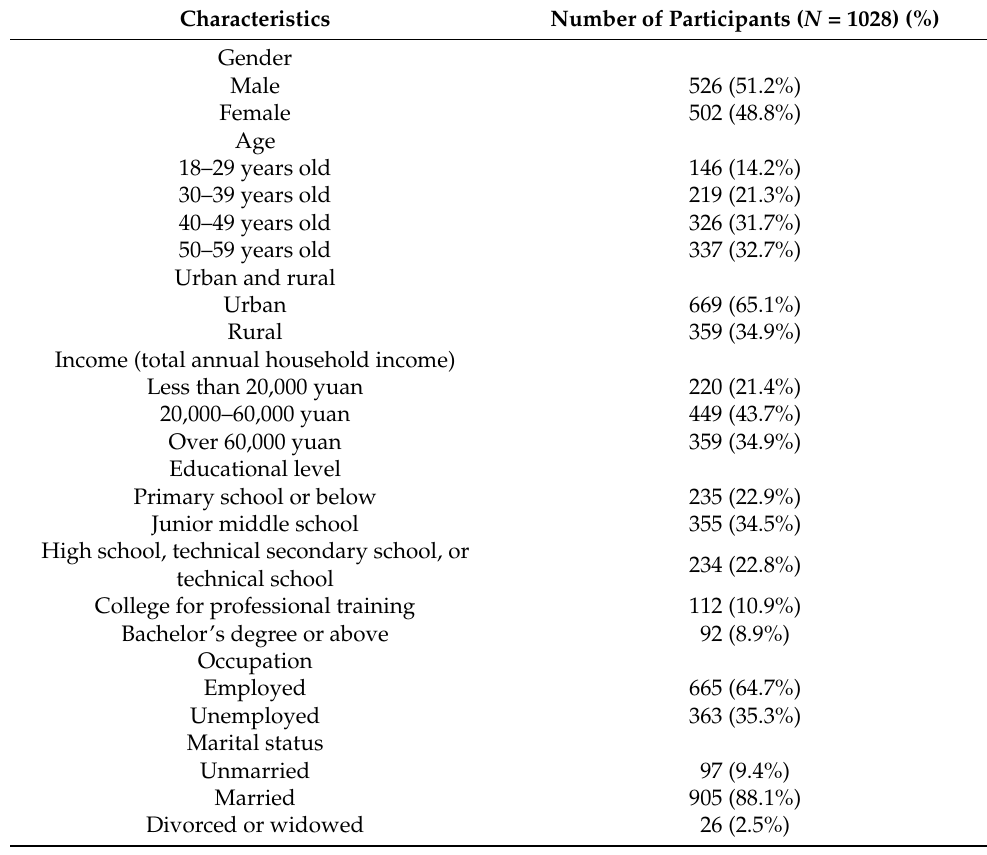
Table 2. Demographic information of the